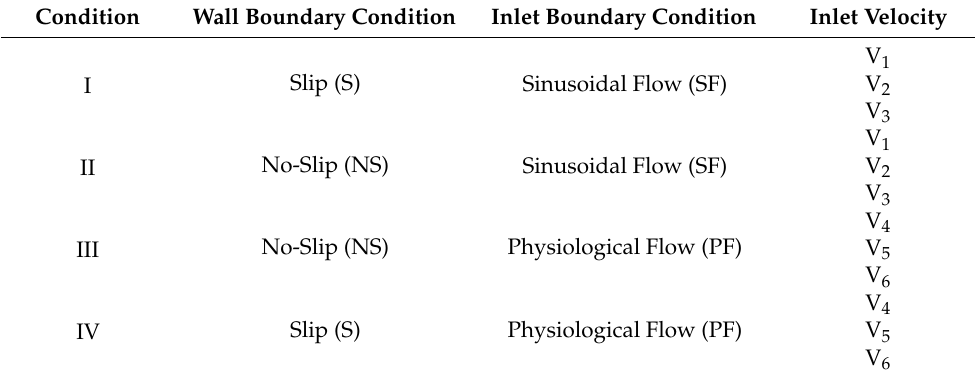
Table 3. Different boundary conditions for numerical